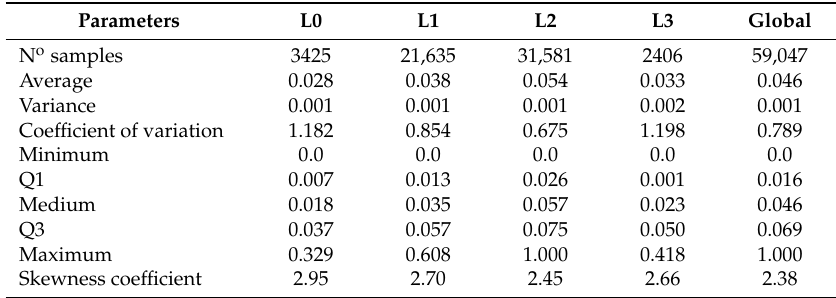
Table A3. Stope wolframite quantity statistics.